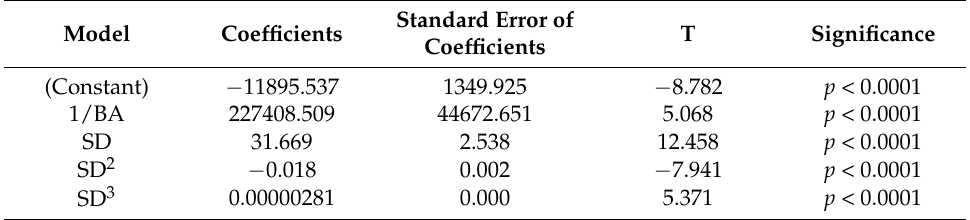
Figure 6. MOEd values in relation to the stand density and to the basal area. Table 3. Statistical parameters obtained in the model and their significance (BA: basal area; SD: number of trees per hectare; T: results of the Student t -test).